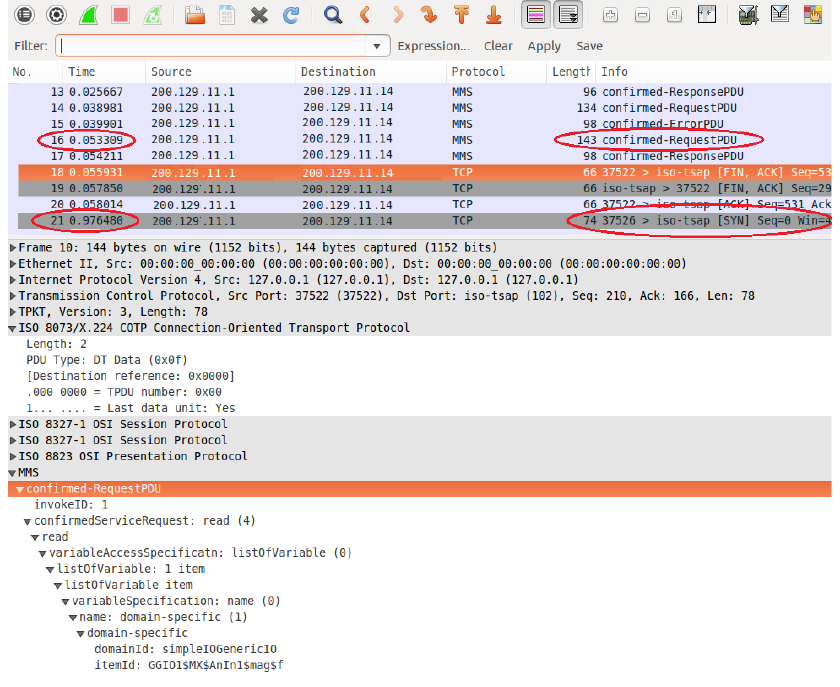
Figure 10. Screenshot of the confirmed IEC 61850 request captured by the pcap (packet capture)